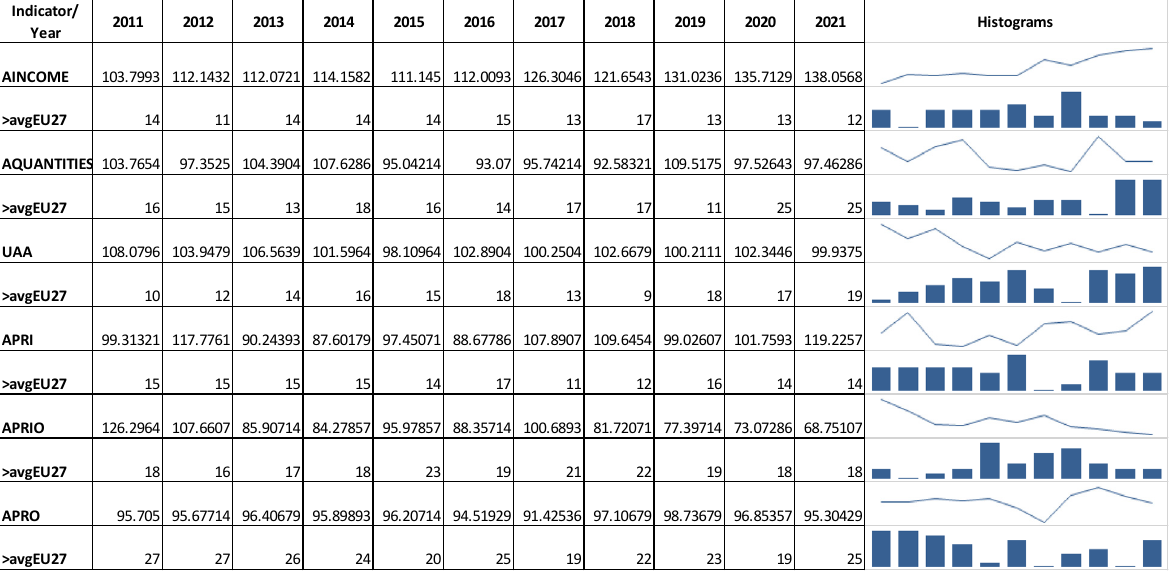
Figure 3. Table of vulnerabilities.